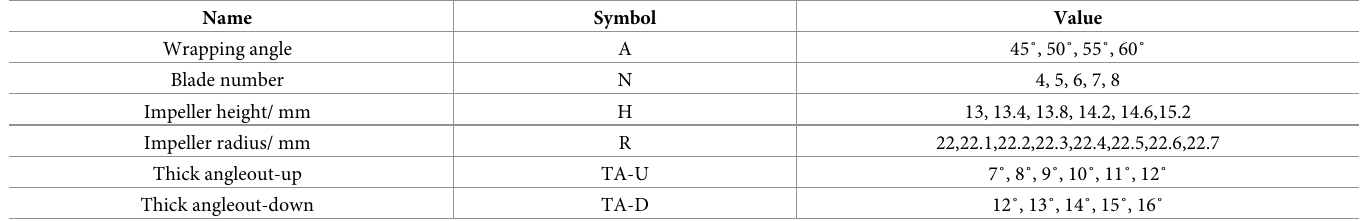
Table 3. Parametric values for impeller.